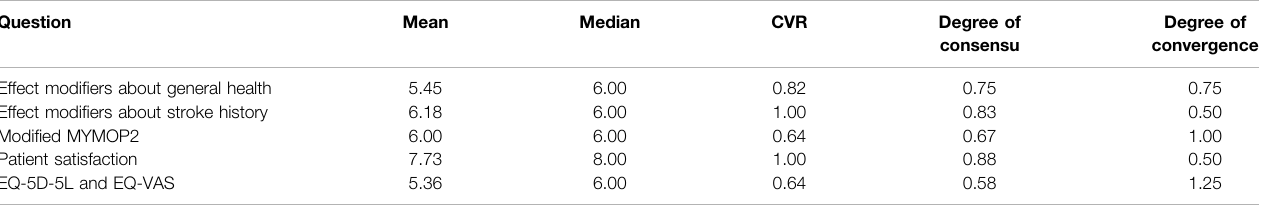
CVR, critical value of ≥ 0.636 — suitable for 11 panelists — was judged to suggest consensus among the panelists. A degree of consensus of ≥ 0.75 and a degree of convergence of ≤ 0.5 were judged that agreement among panel experts is achieved.